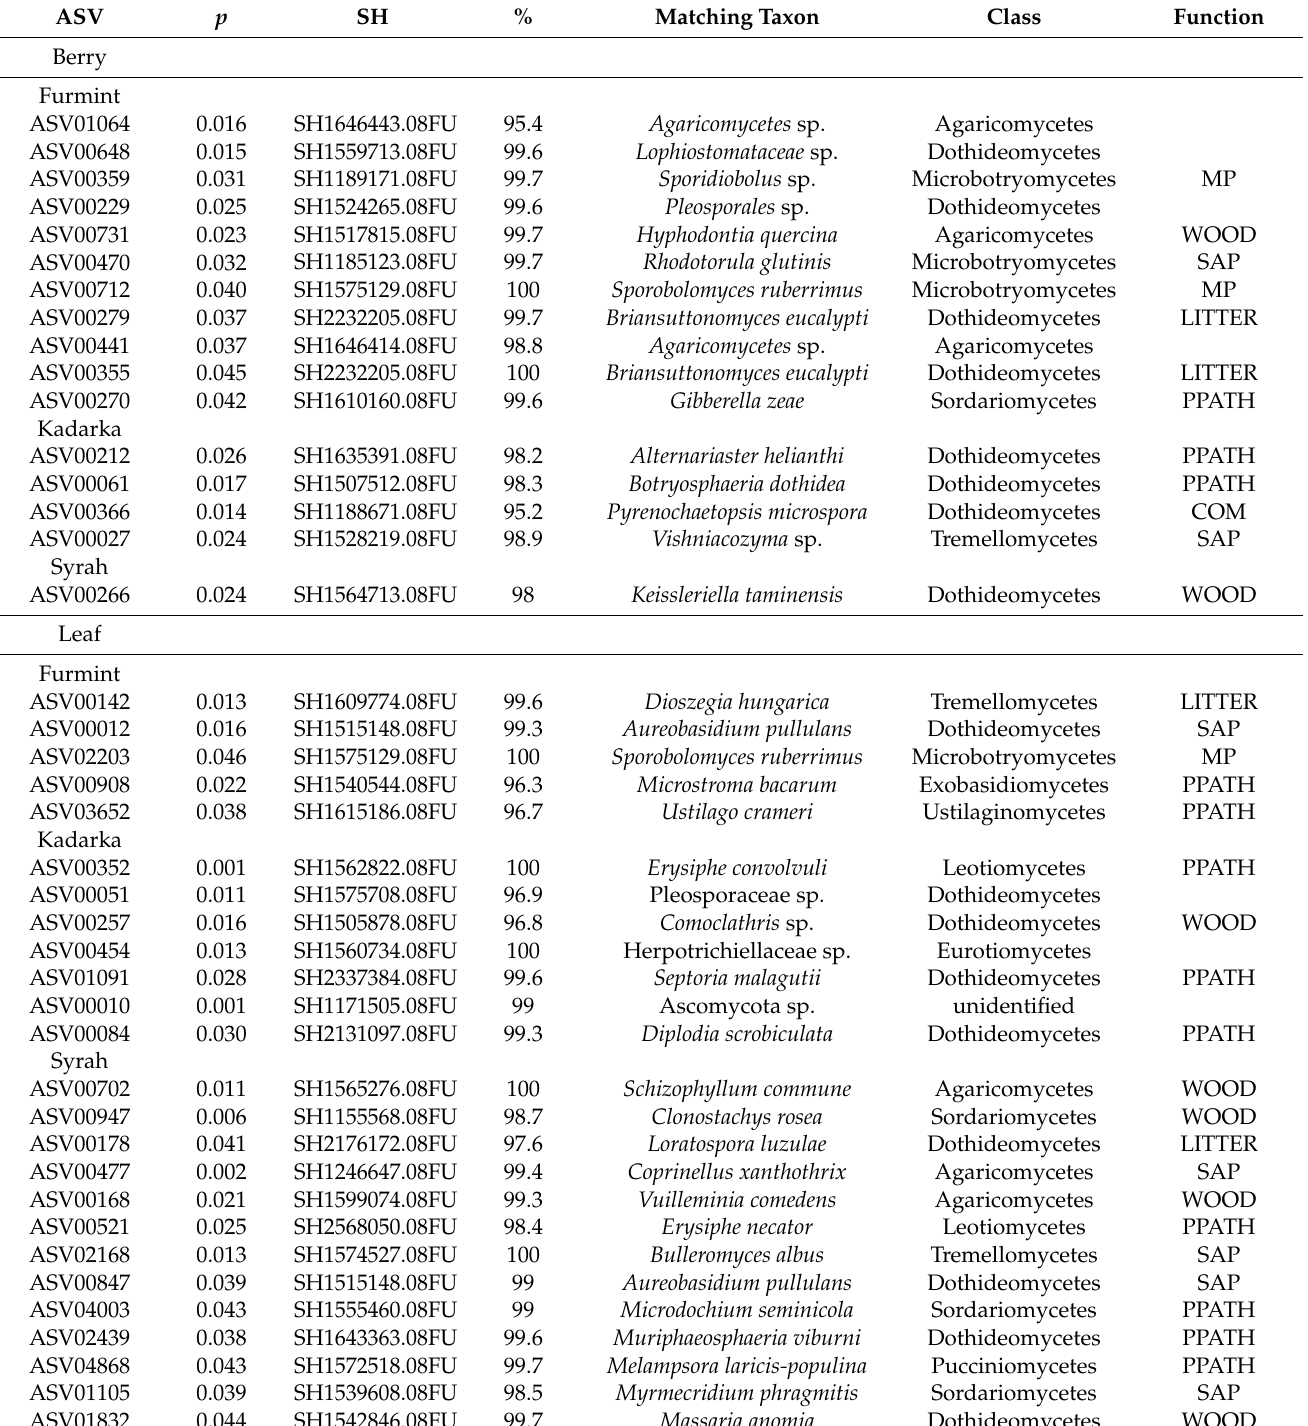
Table 1. The list of indicator ASVs significantly associated with berries or leaves of a specific scion cultivar with the corresponding p -value, matching species hypothesis, ITS2 rDNA sequence similarity (%), taxonomic classification, and assigned functional guild of the most similar matching sequence in the UNITE+INSD dynamic species hypotheses database (version released on 10 May